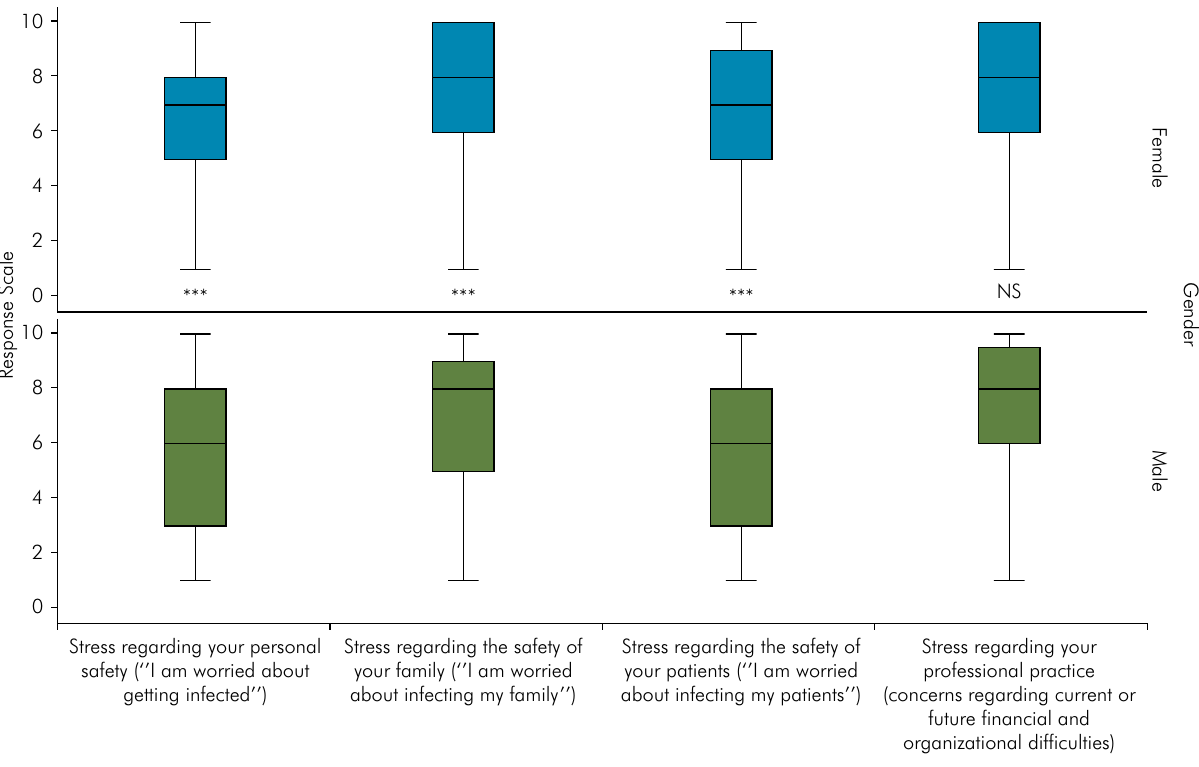
Figure 2. Box-plot representing the statistical relation of gender and stress scale responses. [Data represented as median (horizontal bars inside the box) and range (Y-error bars). *** = represents significant difference (p < 0.001). NS= Non-significant (p >